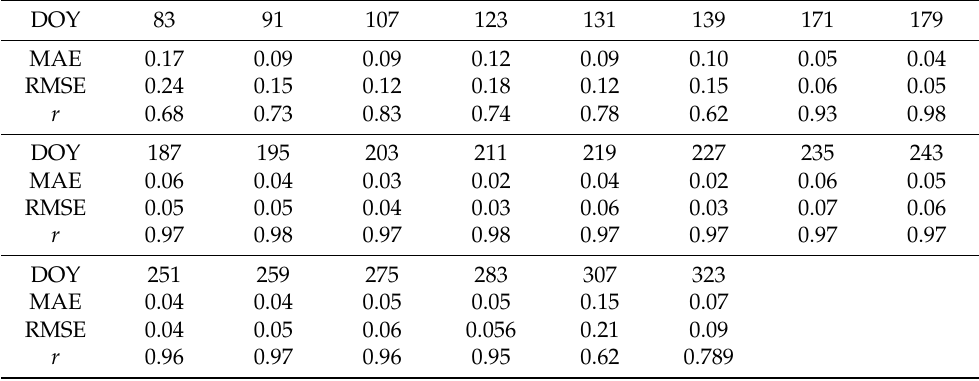
Figure 10. Bar graph of NDVI predictions statistics (MAE, RMSE, and r ) at the NRM area. Table 7. Quantitative validation of NDVI for all input days at the NRM area.